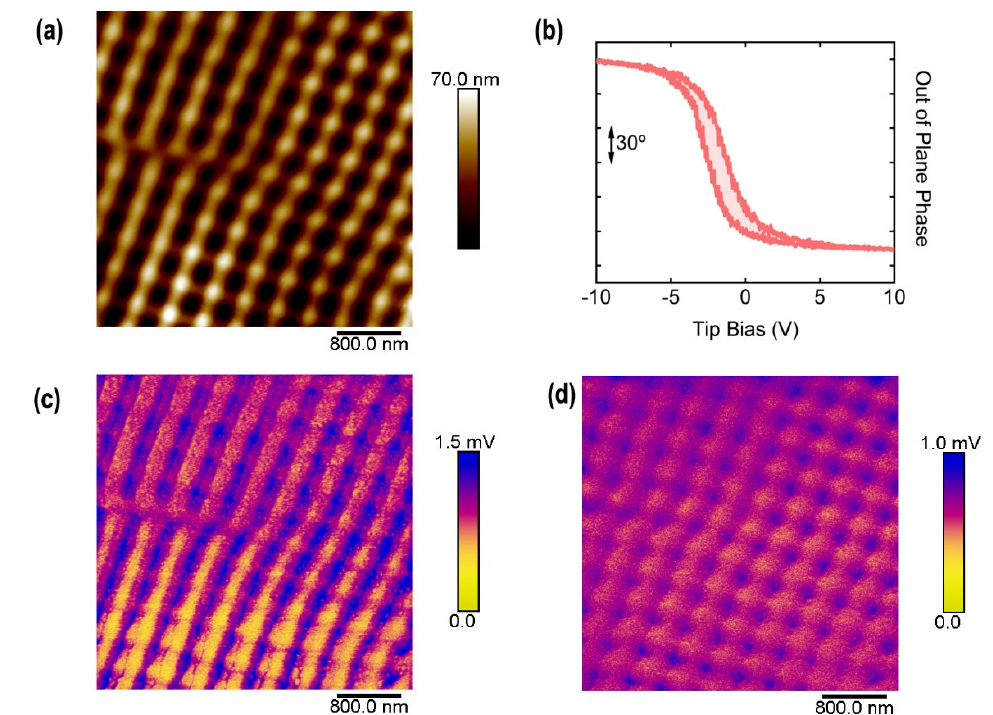
Figure 7. AFM height ( a ) and PFM results ( b – d ) of a patterned functional polymer surface exhibiting ferroelectricity. ( b ) Hysteresis of the out-of-plane PFM phase as a function of a DC bias applied to the conducting AFM tip. ( c ) Out-of-plane amplitude mapping of the patterned surface. ( d ) In-plane amplitude mapping of the patterned surface.